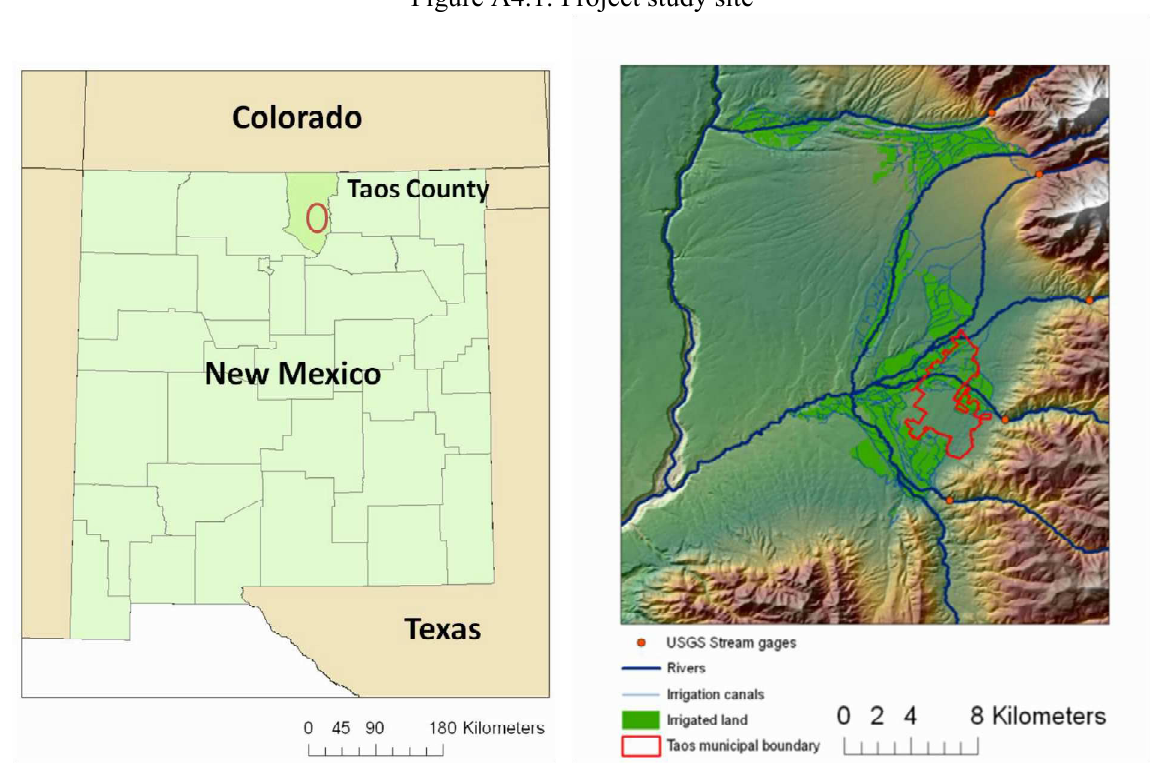
Figure A4.1: Project study